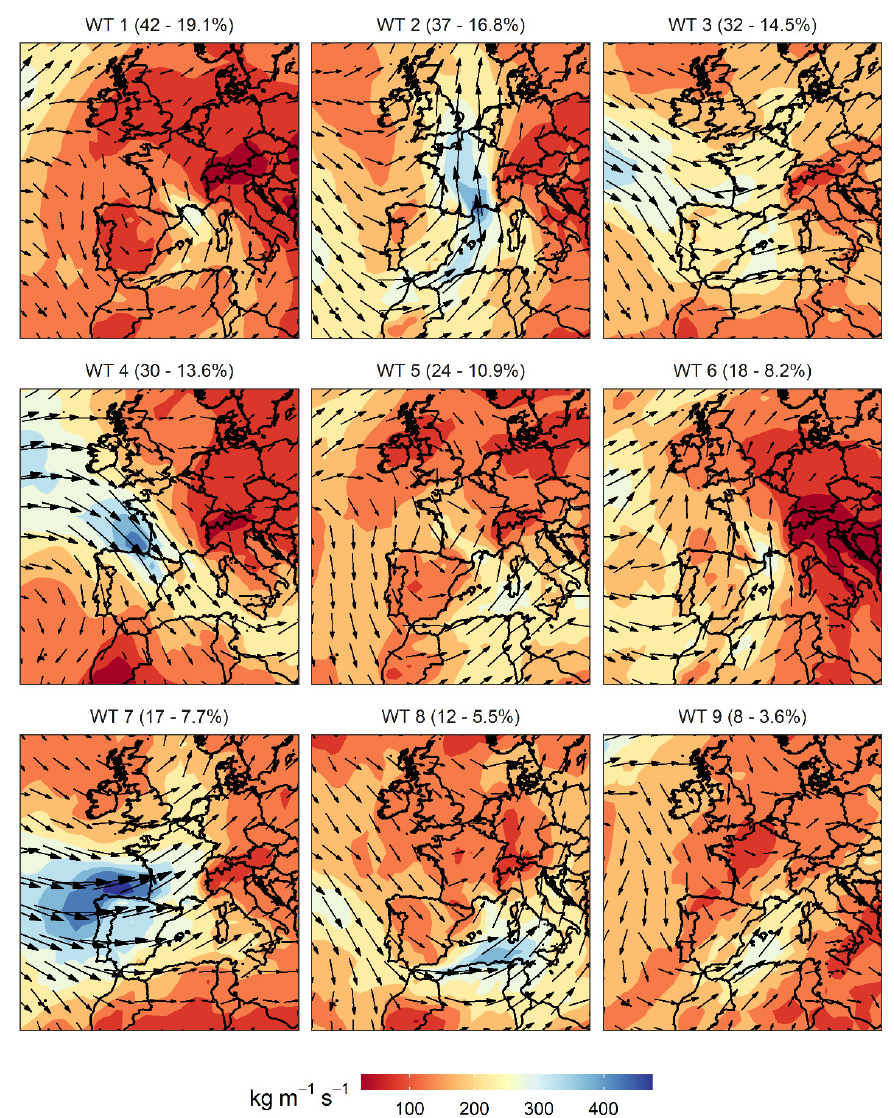
Figure 5. Vertically integrated water vapor transport (IVT) intensity (shaded colours, kg m − 1 s − 1 ) and direction (vectors) of the 9 most frequent atmospheric patterns associated with torrential precipitation in the western Mediterranean region. Above each map, the number of days assigned to each synoptic pattern and their percentages with respect to the total are shown in parentheses.